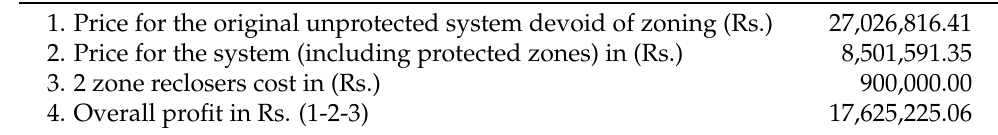
Table 8. Cost components associated with the optimal placement of reclosers in three zones of the 69-bus RDS exhibited in Figure